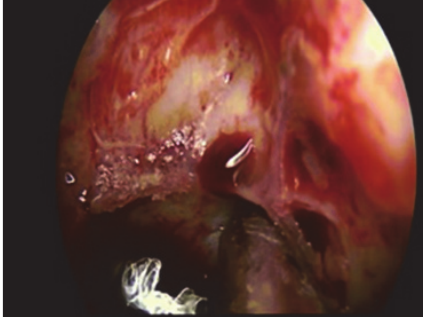
Figure 6: Endoscopic image: posterior ethmoidal artery between the optic nerve and the carotid canal.